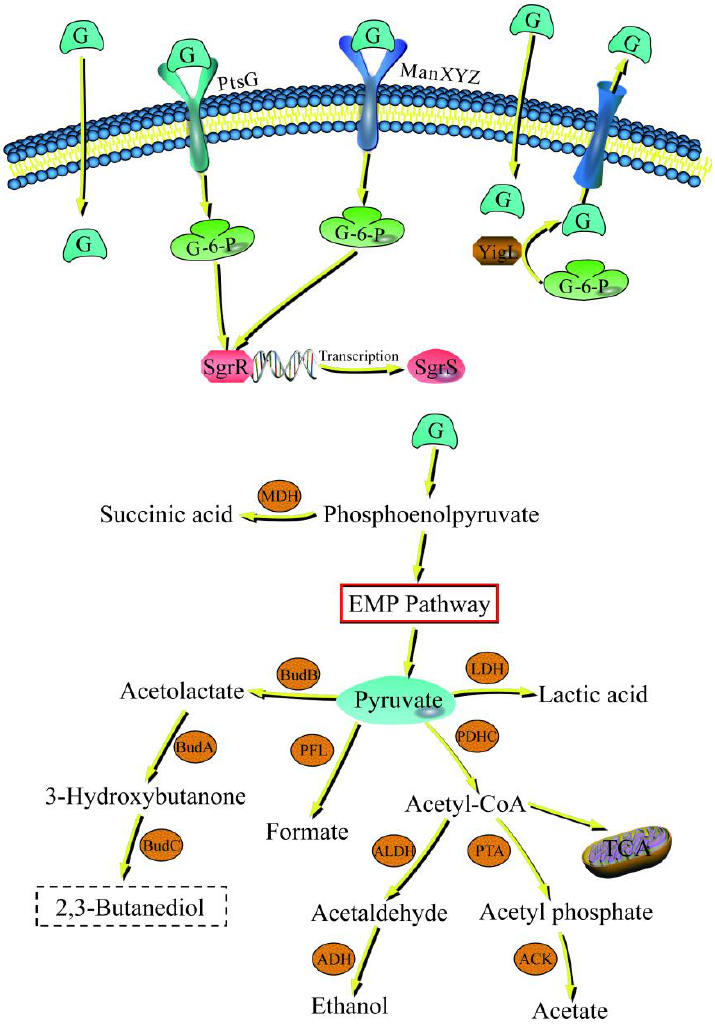
Figure 1. Carbohydrates in vitro enter cells and become G-6-P through transporters encoded by ptsG and manXYZ . G-6-P stimulates the transcription of SgrR into SgrS. sRNA-SgrS positively regulates yigL mRNA and negatively regulates ptsG mRNA and manXYZ mRNA. Intracellular glucose is used for bacterial fermentation to produce 2,3-BD.